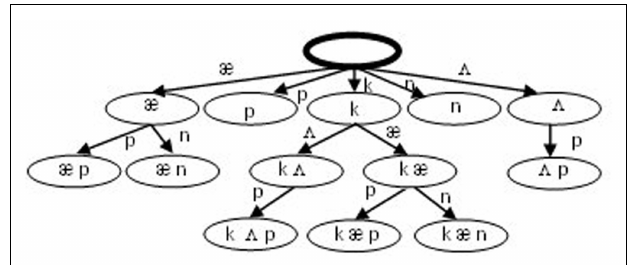
FIGUREA1 |An example of a chunk hierarchy within the model. In this instance, the chunks for “ ,” “ ,” and “ ” have each been learnt incrementally. Each chunk is represented by an ellipse.The topmost chunk (the “root”) is always